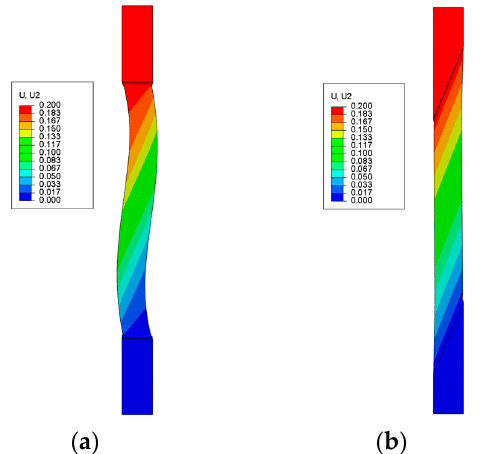
Figure 3. Deformation plots of 15° off-axis tension specimens: ( a ) 15° off-axis tension specimen with rectangle end-tabs; ( b ) 15° off-axis tension specimen with oblique end-tabs.